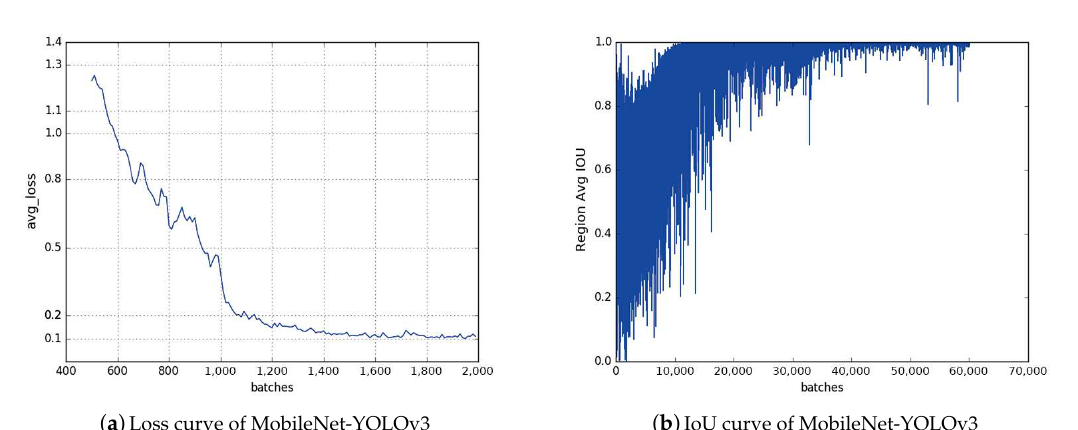
Figure 16. Loss and intersection over union (IoU) curves of MobileNet-YOLOv3.